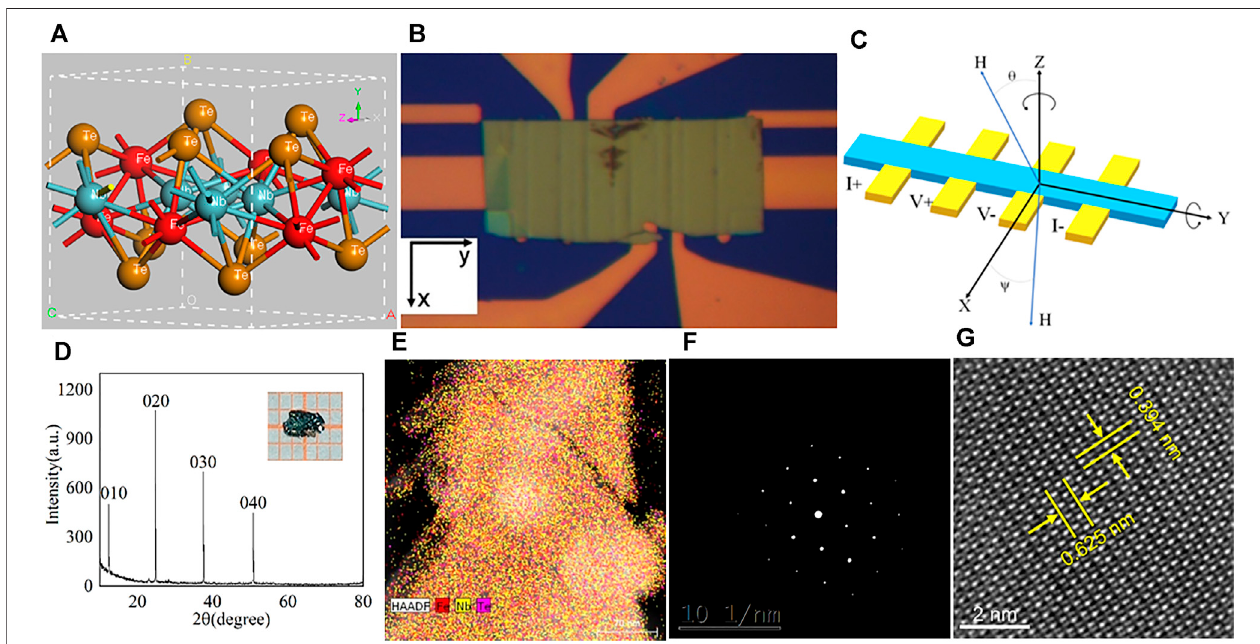
FIGURE 1 | (A) Diagram of the FeNbTe 2 unit cell and the lattice position of magnetic elements Fe with red balls. (B) Optical image of FeNbTe 2 micro-nano device; electrodes are parallel to each other. The size of the fi lm is about 80 μ m · 30 μ m. (C) Schematic of the experimental con fi guration for anisotropic magnetoresistance on thexyandyzplanes,respectively. (D) XRDpatternofFeNbTe 2 singlecrystal.TheinsetshowstheopticalimageoftheFeNbTe 2 crystal. (E) EDSmappingofthreekindsof elements: Fe, Nb, and Te. (F,G) SADE and HRTEM images of FeNbTe 2